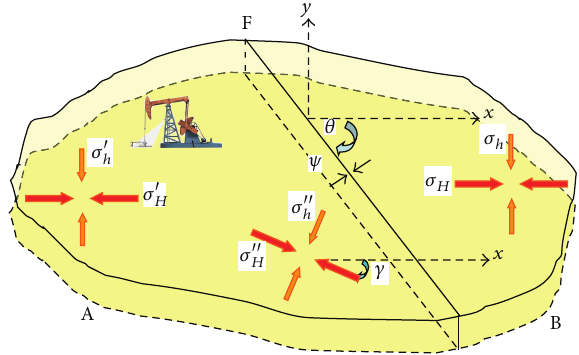
Figure 1: Schematic diagram of geomechanical